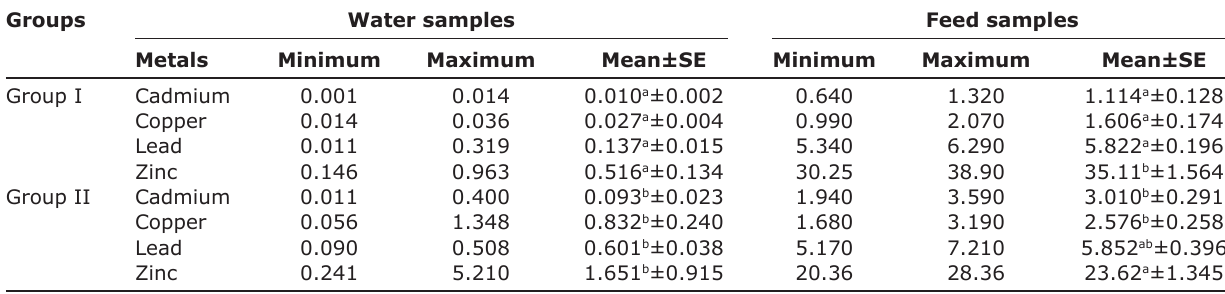
Table-1: Statistical analytical results of mean concentration levels of cadmium, copper, lead, and zinc in water samples and feeds samples (n=20). Groups